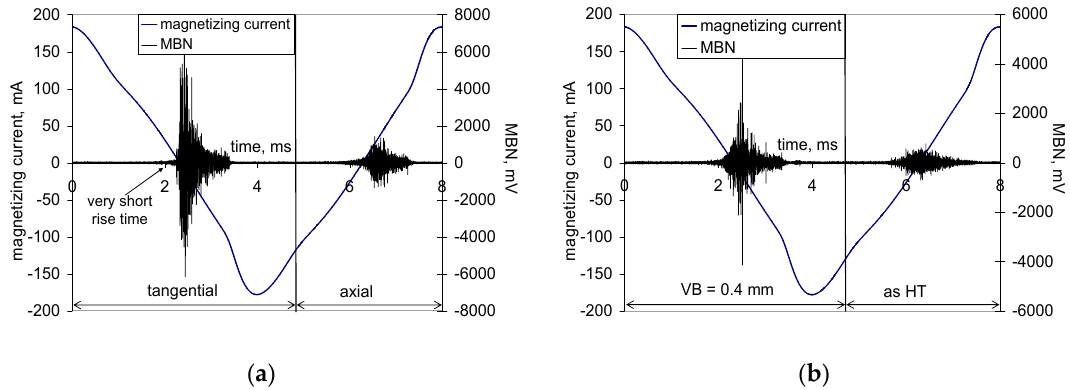
Figure 12. MBN signals: ( a ) for the tangential and axial directions—VB = 0.05 mm, and ( b ) for the tangential direction—VB = 0.4 mm and as HT.